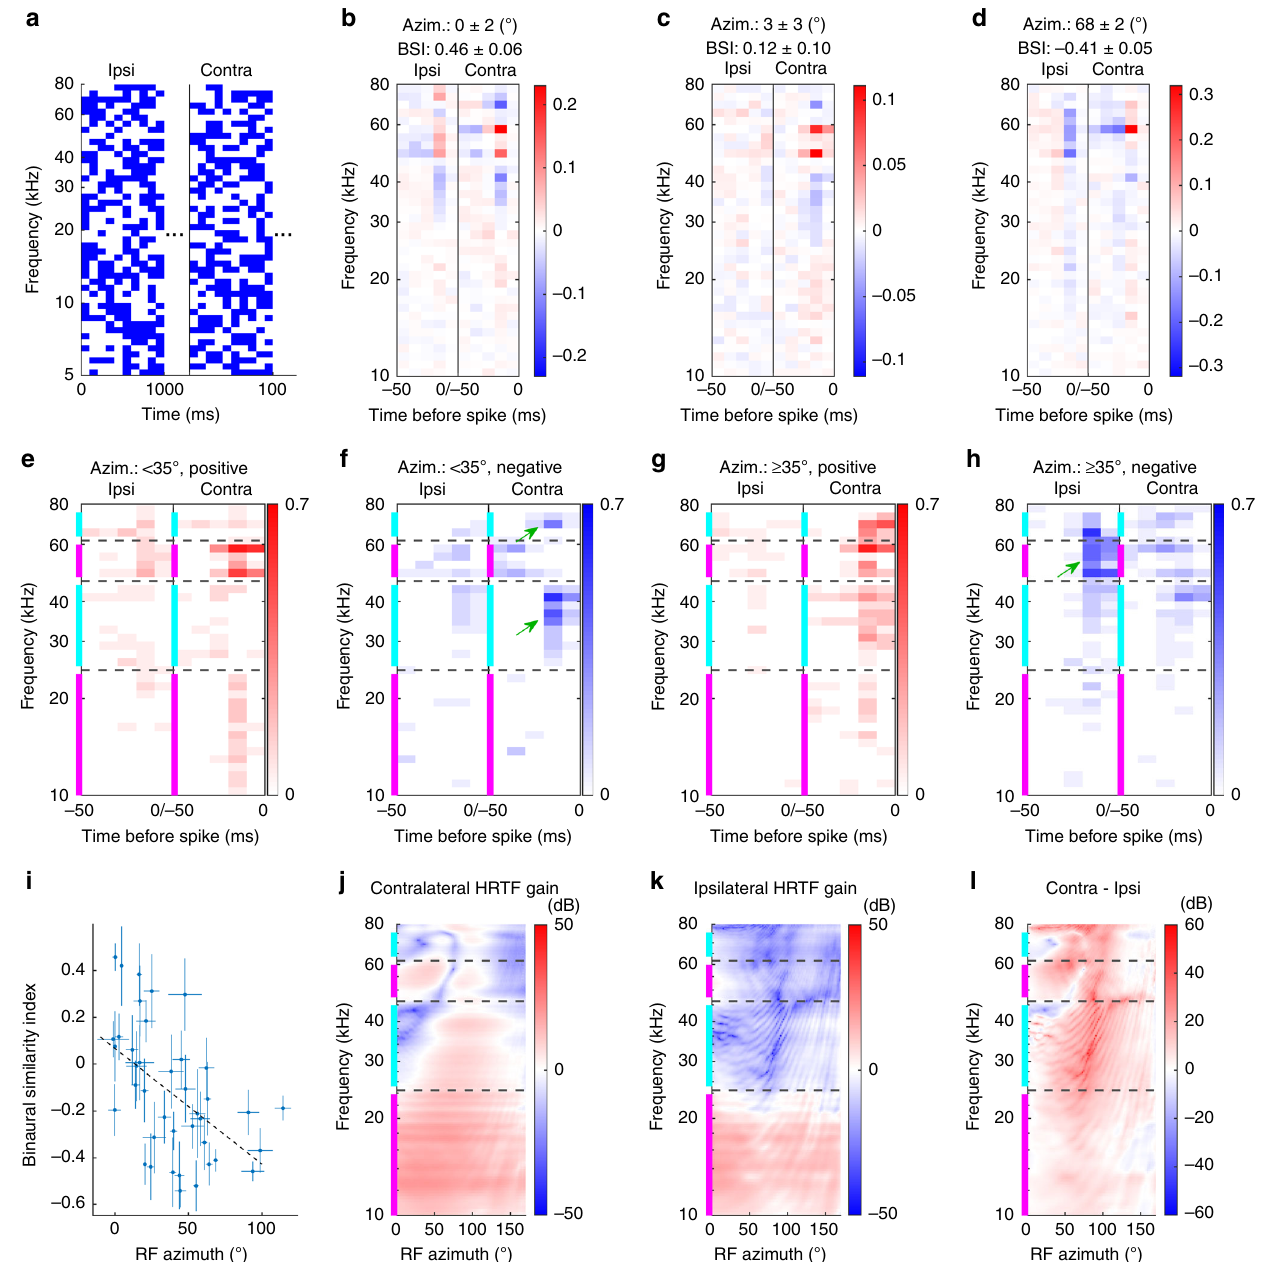
Fig. 5 Spectro-temporal receptive fi elds (STRFs) of the neurons with spatially localized RFs. a The fi rst 100 ms of the dynamic random chord stimulus to the ipsilateral (ipsi; left) and contralateral (contra; right) ears. Blue pixels indicate the presence of a tone. b – d Example STRFs of neurons with frontal RFs ( b , c ) and a lateral RF ( d ). The pixel color indicates the deviation from the stimulus average at the corresponding frequency. (The stimulus average fl uctuates around 0.5 because of the stimulus randomness.) The STRF structures of the two ears are symmetric ( b ), uncorrelated ( c ), and anti-symmetric ( d ), resulting in positive, near-zero, and negative values of the binaural similarity index (BSI; see Methods), respectively. e , f A summary of the positive ( e ) and negative ( f ) structures observed in the neurons with frontal RFs. The pixel color represents the fraction of neurons with a frontal RF that had a signi fi cant structure at the frequency/time before spike. Many frontal neurons exhibited positive structures in the 10 – 24 and 48 – 60 kHz ranges (magenta bands) and negative structures in the 25 – 45 and 63 – 76 kHz ranges (cyan bands) in the contralateral ear (green arrows in f ). g , h Same as e , f for lateral neurons. In contrast to the frontal neurons, these neurons show positive structures in the contralateral cyan bands and negative structures in the ipsilateral upper magenta band (green arrow in h ). i A scatter plot of the RF azimuth and the BSI. The errors in X -axis are derived from the Kent distribution fi ts; the errors in Y -axis are based on the Poisson statistics and arithmetic propagation (see Methods). These are anticorrelated ( r = − 0.52 ( p = 5e − 4; using the “ corrcoef ” function in Matlab), slope: − 0.0049 ± 0.0013° − 1 ), indicating that lateral neurons prefer larger binaural contrast. j – l HRTFs measured in the horizontal plane for the contralateral ( j ) and ipsilateral ( k ) ears, and their difference ( l ). The values indicate the gain relative to a free- fi eld measurement without the head. The spectral structures of the frontal part (small azimuth) of the contralateral ear ( j ) match well with the frequency tunings of the neurons in e , f